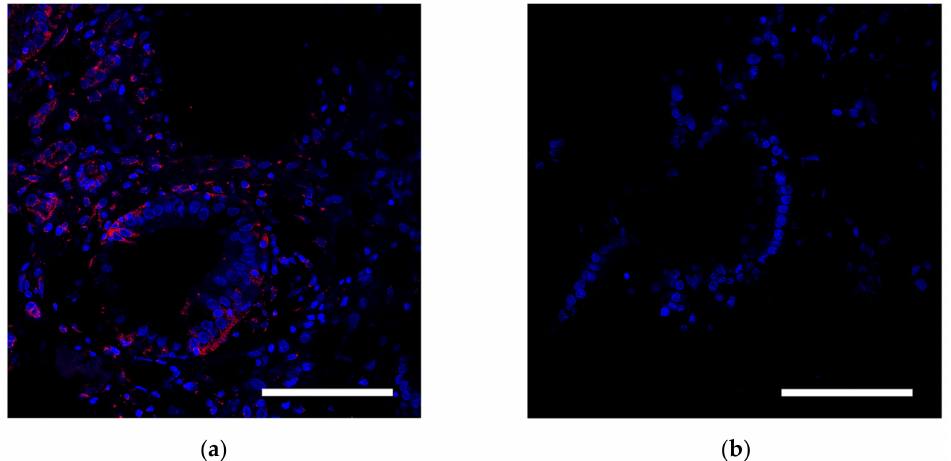
Figure 4. Histological analysis of the kidney. ( a ) Assessment of the SPION-labeled MCS accumulation in the kidney. Nuclei were stained with DAPI (blue). SPIONs were detected by reflected laser scanning (red). ( b ) Control (healthy rabbit without SPIONs administration. Scale bars, 100 µ